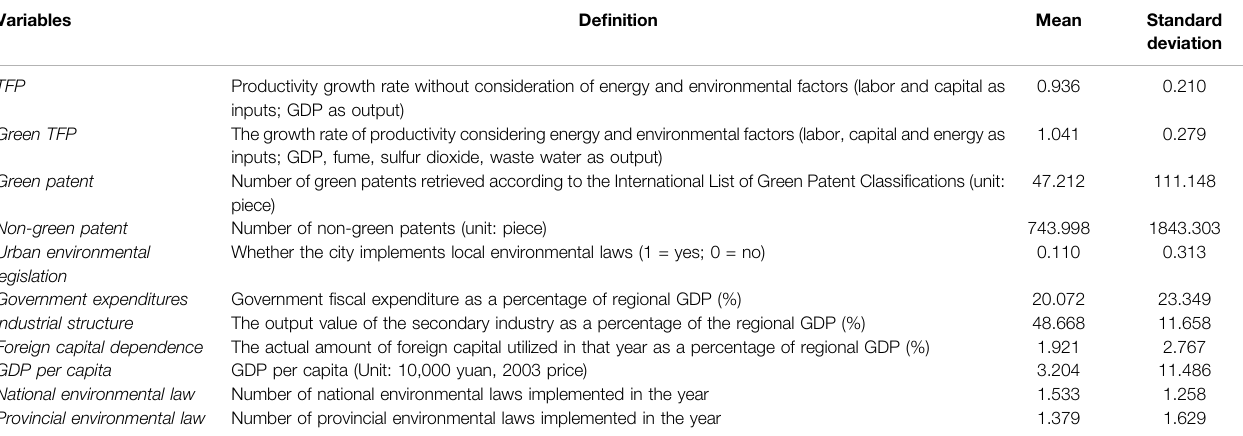
TABLE 2 | Descriptive statistics of the main variables. Variables